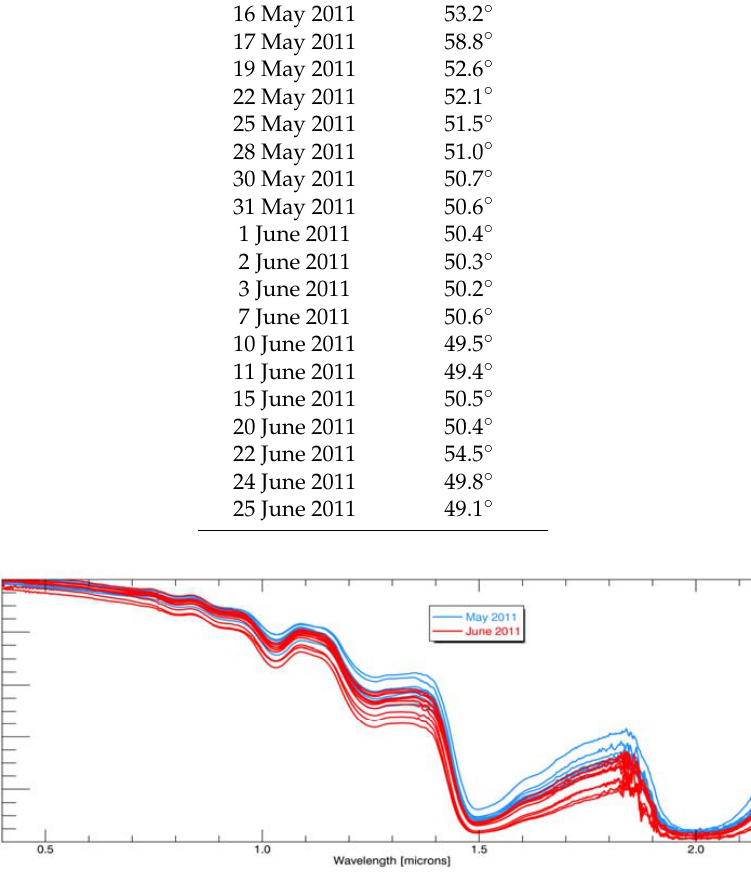
Figure 6. Snow spectral albedo measurement by the ASD spectroradiometer in May (blue lines) and in June (red lines).